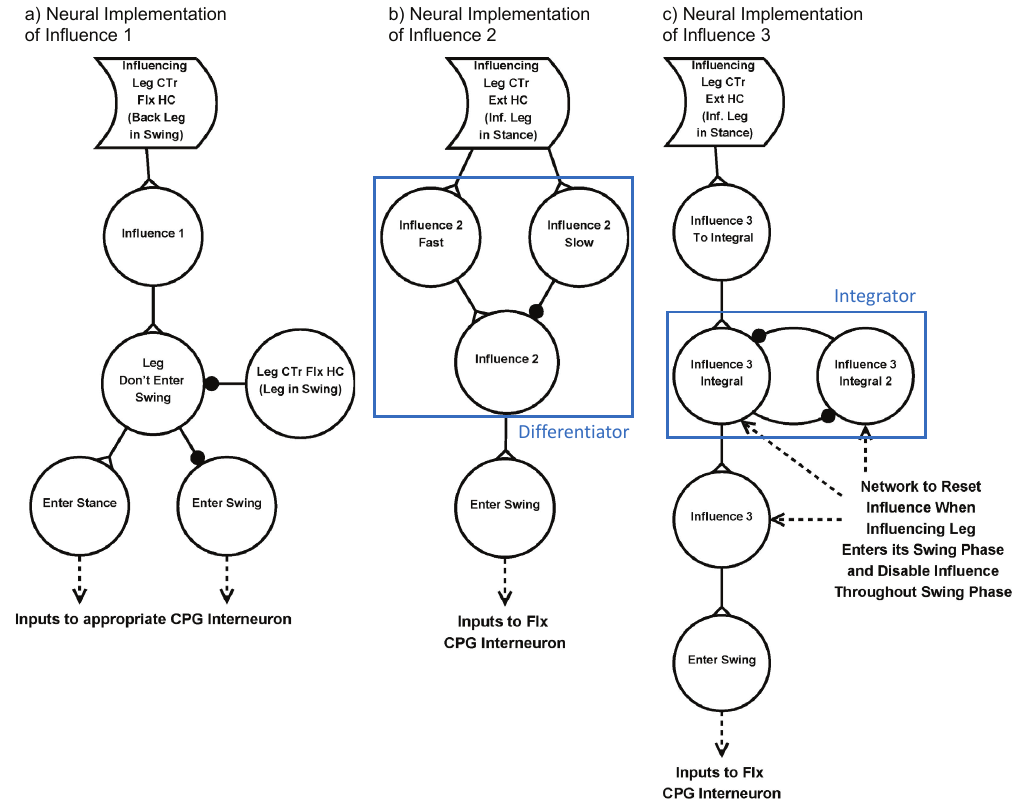
Figure 6. Neural Implementation of three “Holk Cruse’s rules” [29]. ( a ) Influence 1 inhibits the start of swing phase when the posterior leg is in its swing phase; ( b ) Influence 2 momentarily excites the start of swing phase in the rostral leg when the caudal leg enters its stance phase. To capture this, we use a differentiator network [40]; ( c ) Excites the start of swing phase while the anterior leg is in its stance phase, increasing in strength over time. To capture this, we use an integrator network [40]. Synapses with black circles and white triangles represent inhibitory synapses and excitatory synapses,